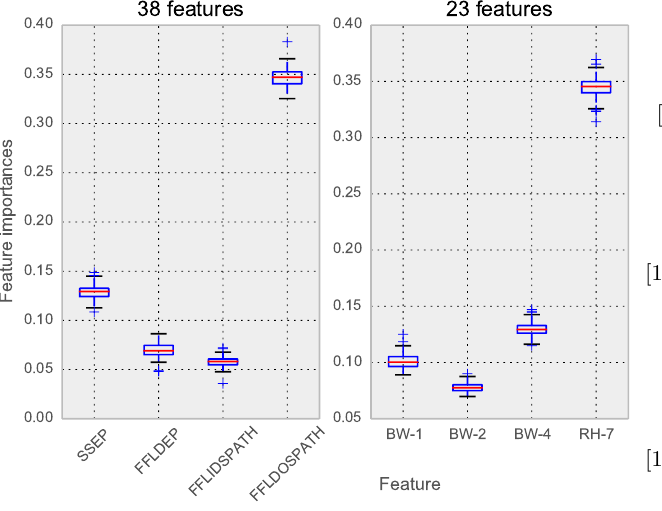
Figure 6: Feature importances as determined by random forest regression for models with 38 features and 23 features respectively for network size 100 at 75% loss. While the feature source to sink edge per- centage is termed as SSEP, the percentage of FFL direct edges is termed FFLDEP. The features 10, 11 as explained in Section 2.4 are FFLIDSPATH and FFLDOSPATH. Refer to Table 1 and Table 2 for definitions of BW-1, BW-2, BW-4, and RH-7 Higher feature importance is better